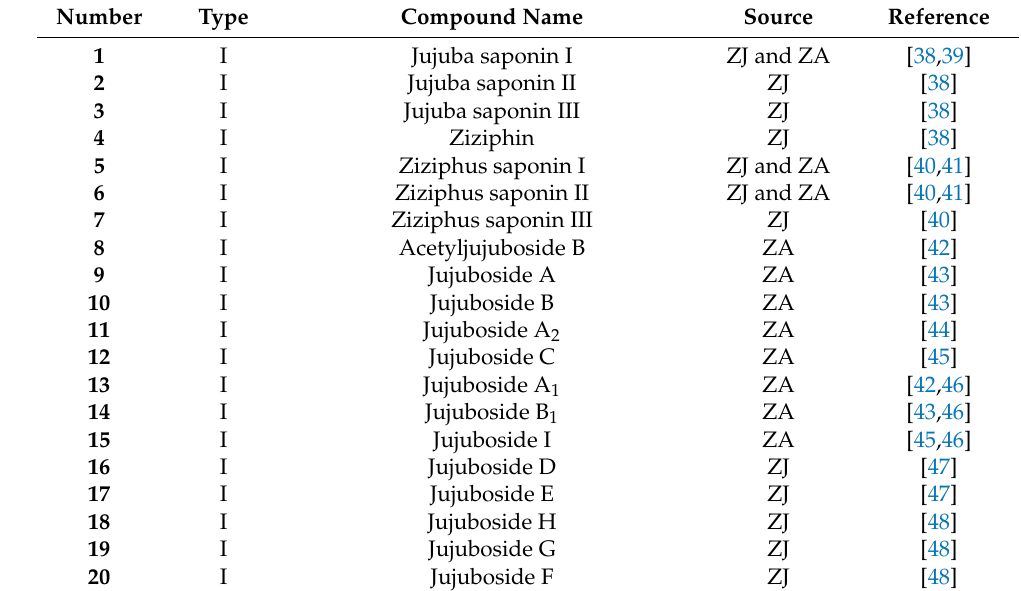
Figure 2. Chemical structures of triterpenoid saponins in ZJ and ZA. Table 2. Saponins from ZJ and